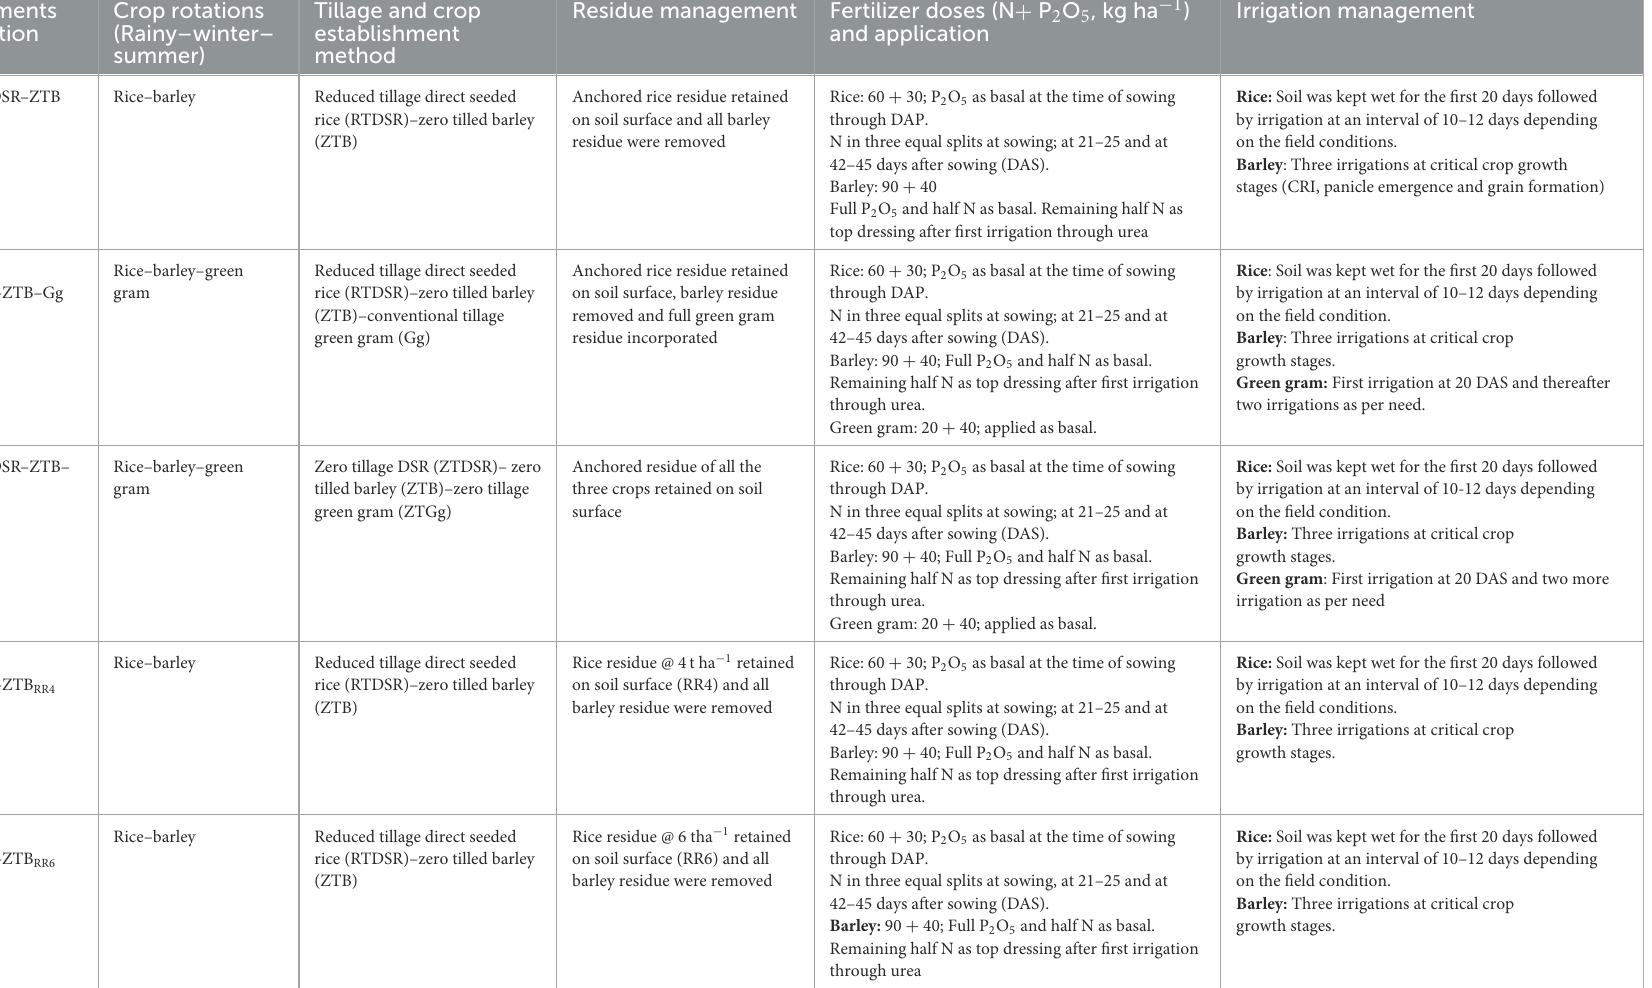
TABLE 1 Detailed description of tillage and residue management practices in rice–barley cropping system. Treatments